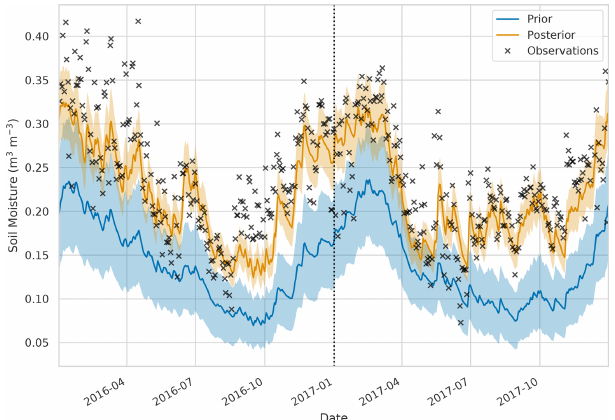
Figure 8. Time series of soil moisture for 52.96 ◦ N, 0.40 ◦ W. Black crosses: SMAP observations, blue line and shading: prior JULES mean and ensemble spread, orange line and shading: posterior en- semble mean and spread. The dotted black line represents the end of the assimilation window and start of the hindcast period.